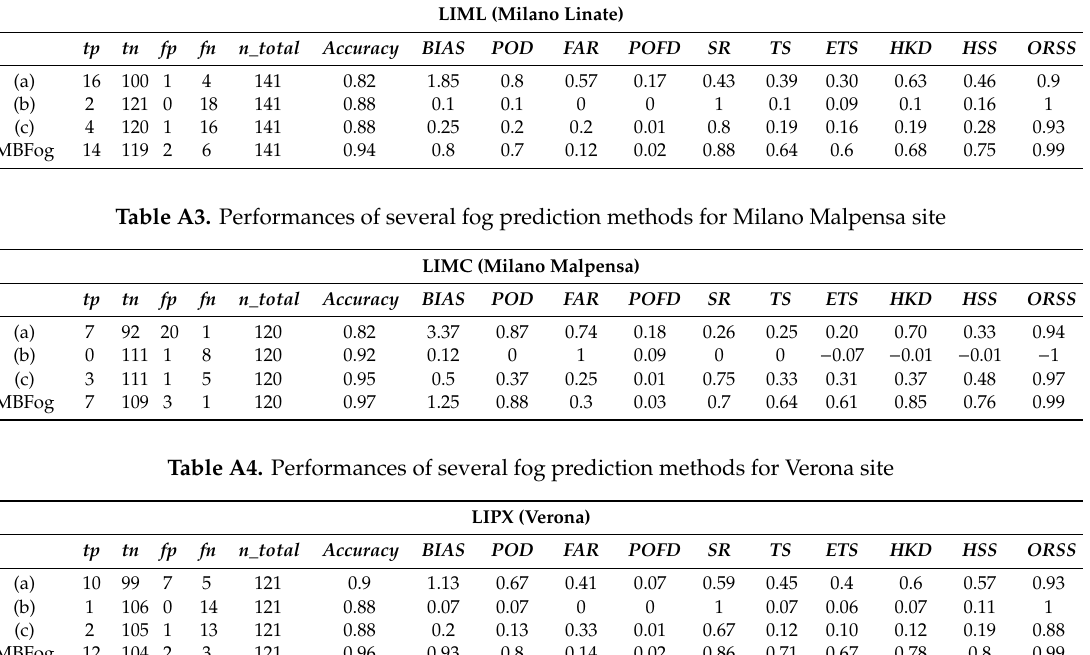
Table A2. Performances of several fog prediction methods for Milano Linate site LIML (Milano Linate)